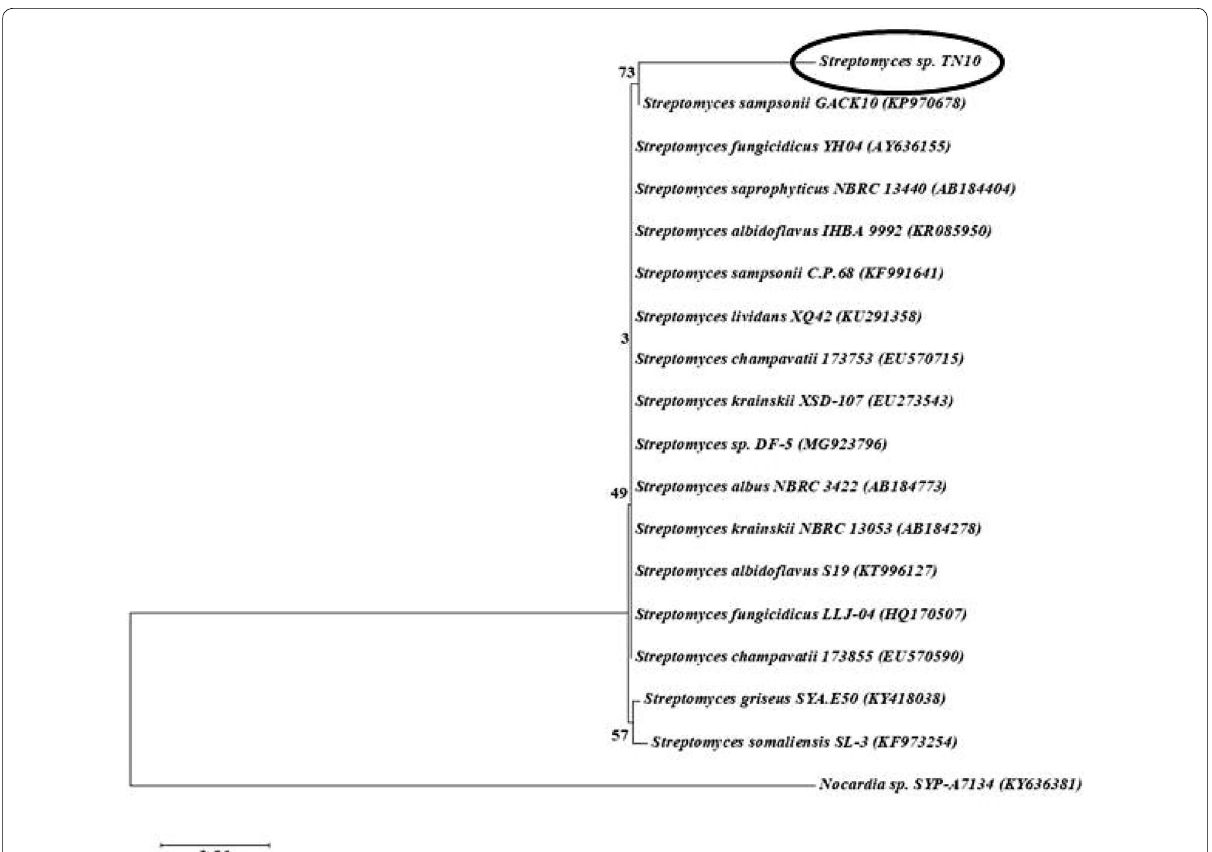
Fig. 1 The phylogenetic relationship of the potential actinobacterial strain TN10 based on 16S rRNA gene homology. The tree was constructed using the neighbor-joining method with pairwise-deletion model analyses, which were implemented in the molecular evolutionary genetics analysis (MEGA), version 6.0 program. The resultant tree topologies were evaluated by bootstrap analysis based on 1000 replicates. Nocardia sp. SYP-A7134 was used as out